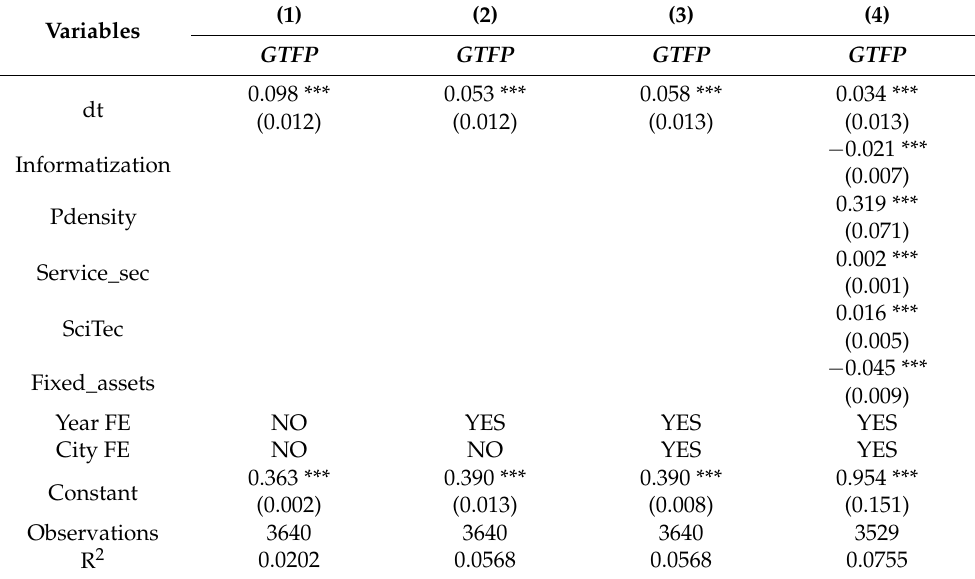
Table 4. Baseline regression results.